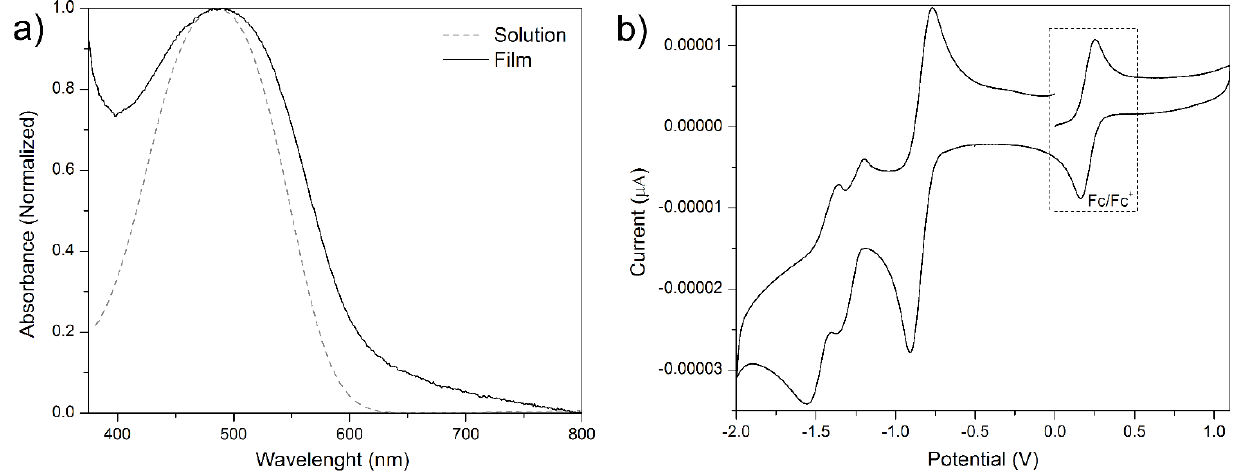
Figure 2. ( a ) UV-vis normalized absorptions of [5]helicenebenzoquinone in solution (CHCl 3 ) and as a thin film; ( b ) cyclic voltammetry; 10 −3 M CH 2 Cl 2 , 0.1 M NBu 4 PF 6 , T = 25 °C, scan rate: 100 mVs −1 , reference electrode: Ag/AgCl, working electrode: glassy carbon. Fc/Fc + was used as internal reference (E 1/2-ferrocene = 0.21 V). Table 1. Thermal, electrochemical and spectroscopic characterization of [5]helicenebenzoquinone 1. m.p